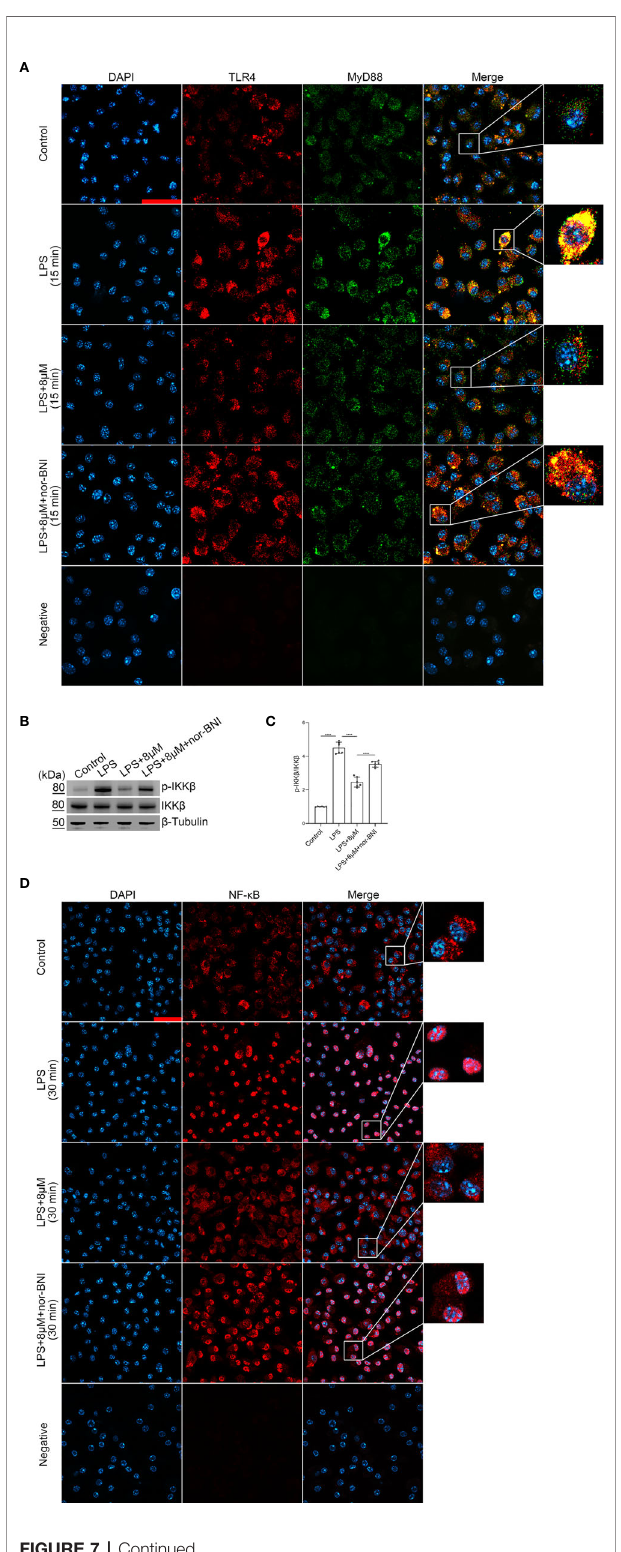
FIGURE 7 | Butorphanol prevented the interaction of MyD88 with TLR4 and inhibited NF- k B activation through KOR in M1-polarized BMDMs. Macrophages were collected and cultured from the bone marrow of mice and incubated with LPS (1 m g·mL -1 ) alone, butorphanol (8 m M) plus LPS (1 m g·mL -1 ), or nor-BNI (KOR antagonist, 5 m M) plus butorphanol (8 m M) and LPS (1 m g·mL -1 ) for 15 min or 30 min. Cells were pretreated with nor-BNI for 30 min. (A) To observe the interaction of MyD88 with TLR4, cells were fi xed, permeabilized, and stained, and images were obtained by confocal microscopy. Scale bar: 25 m m. (B) The levels of phosphorylated IKK b and total IKK b were measured by western blot analysis. (C) Densitometric analysis of the phosphorylated IKK b levels in (B) was performed with normalization to the respective total protein. (D) The translocation of NF- k B in cells was examined by confocal microscopy. Scale bar: 25 m m. The results are the means ± SEM of six independent experiments. Statistical analysis was performed by one-way ANOVA followed by Tukey ’ s post hoc test when comparing multiple independent groups. ****P